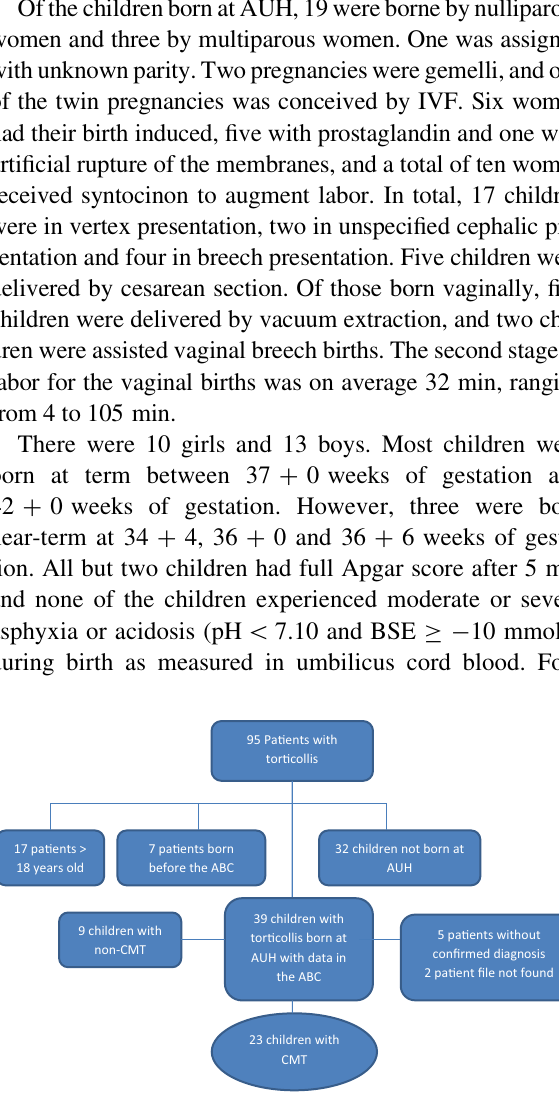
Fig. 1 Flowchart of patient